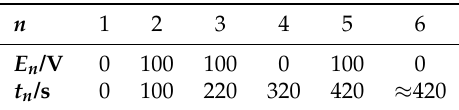
Table 1. Vertices of the potential cycle